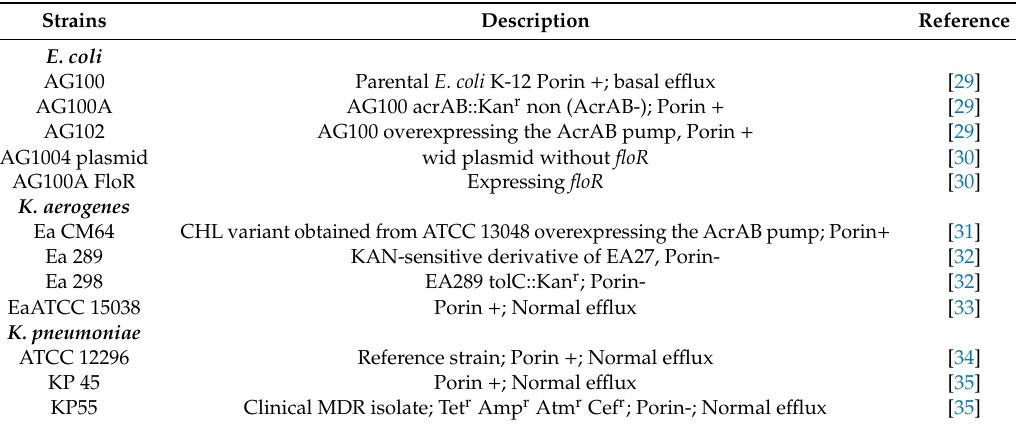
Table 1. Bacterial strains used in this